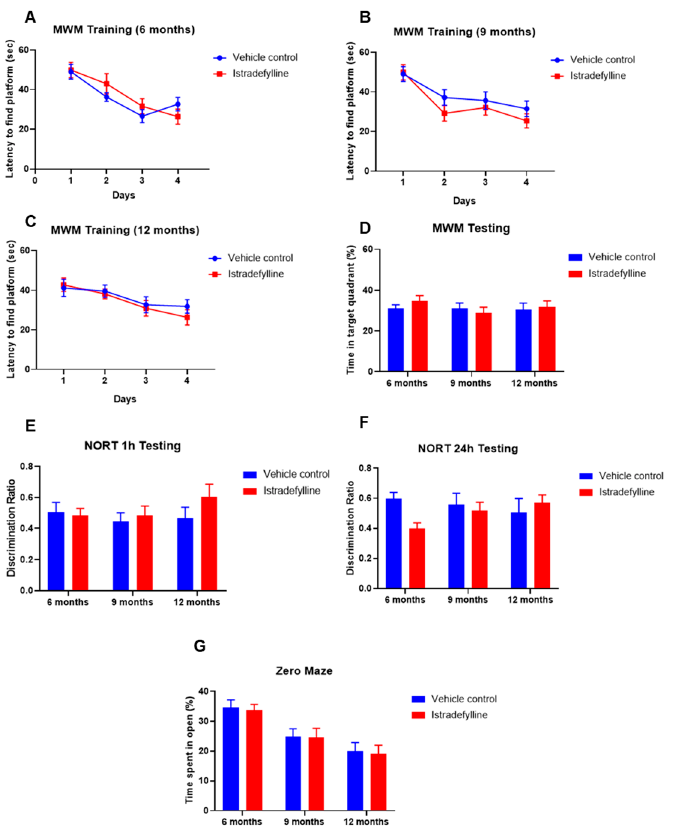
Figure 4. Cognitive studies in ageing mice. ( A – C ) Morris water maze (MWM) spatial memory training in istradefylline- and vehicle-treated mice at ( A ) 6 months, ( B ) 9 months, and ( C ) 12 months of age. ( D ) Final MWM testing in istradefylline-treated and control animals at 6, 9, and 12 months of age. Recognition memory was assessed by the novel object recognition test (NORT) after ( E ) 1 h (short-term memory) and ( F ) 24 h (long-term memory). ( G ) The level of anxiety in istradefylline- treated and control mice assessed by the zero maze test. Data presented as mean ± SEM. Vehicle control, n = 13; istradefylline, n =